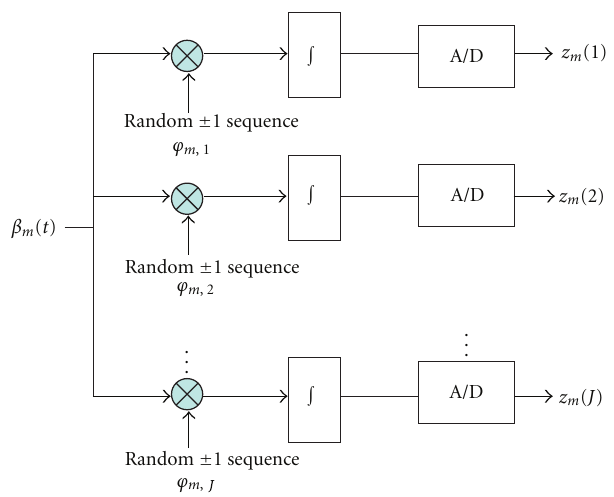
Figure 2: RMPI architecture for the hardware implementation of compressive impulse through-the-wall